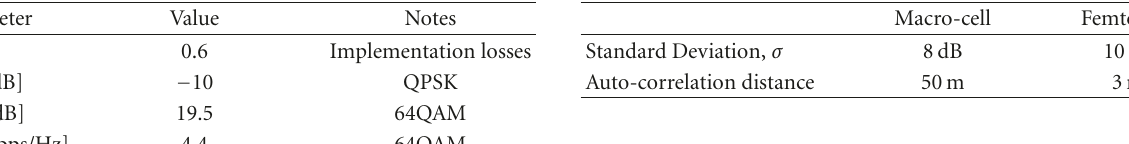
Table 1: Link to system mapping parameters. Table 2: Shadowing